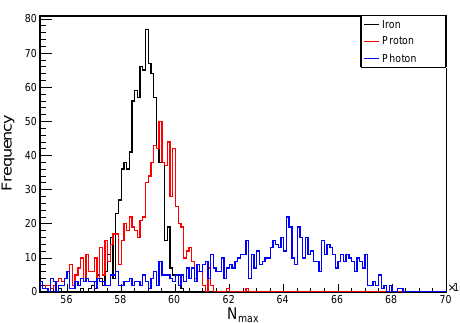
Figure 1. fluctuations of the shower maximum depth X max around the mean shower maximum depth ⟨ X max ⟩ for a primary Figure 2. The N max distribution for primary proton, photon and energy of 10 17 to 10 20 eV [7]. iron (primary energy10 20 eV). Table 1. Comparation between Monte Carlo simulations and Cascade Equations (CE) by CONEX and CORSIKA codes results [7]